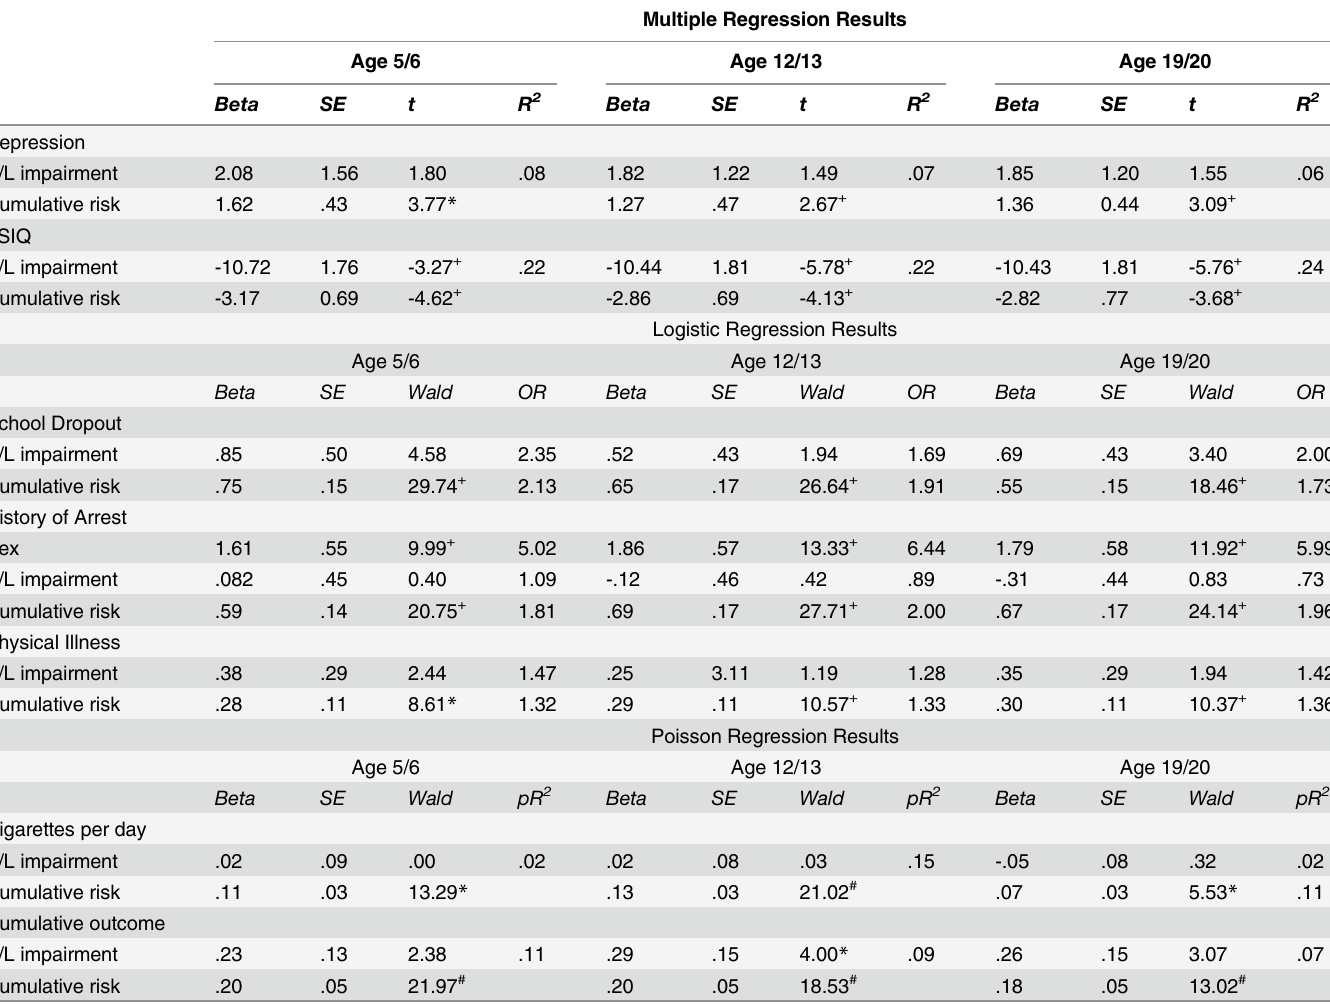
Table 4. Regression Results: Outcomes Regressed on S/L Impairment and Cumulative Risk at Each